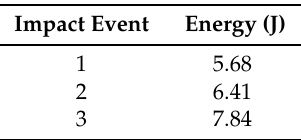
Table 1. Multiple impact events on the SHM layer plate.